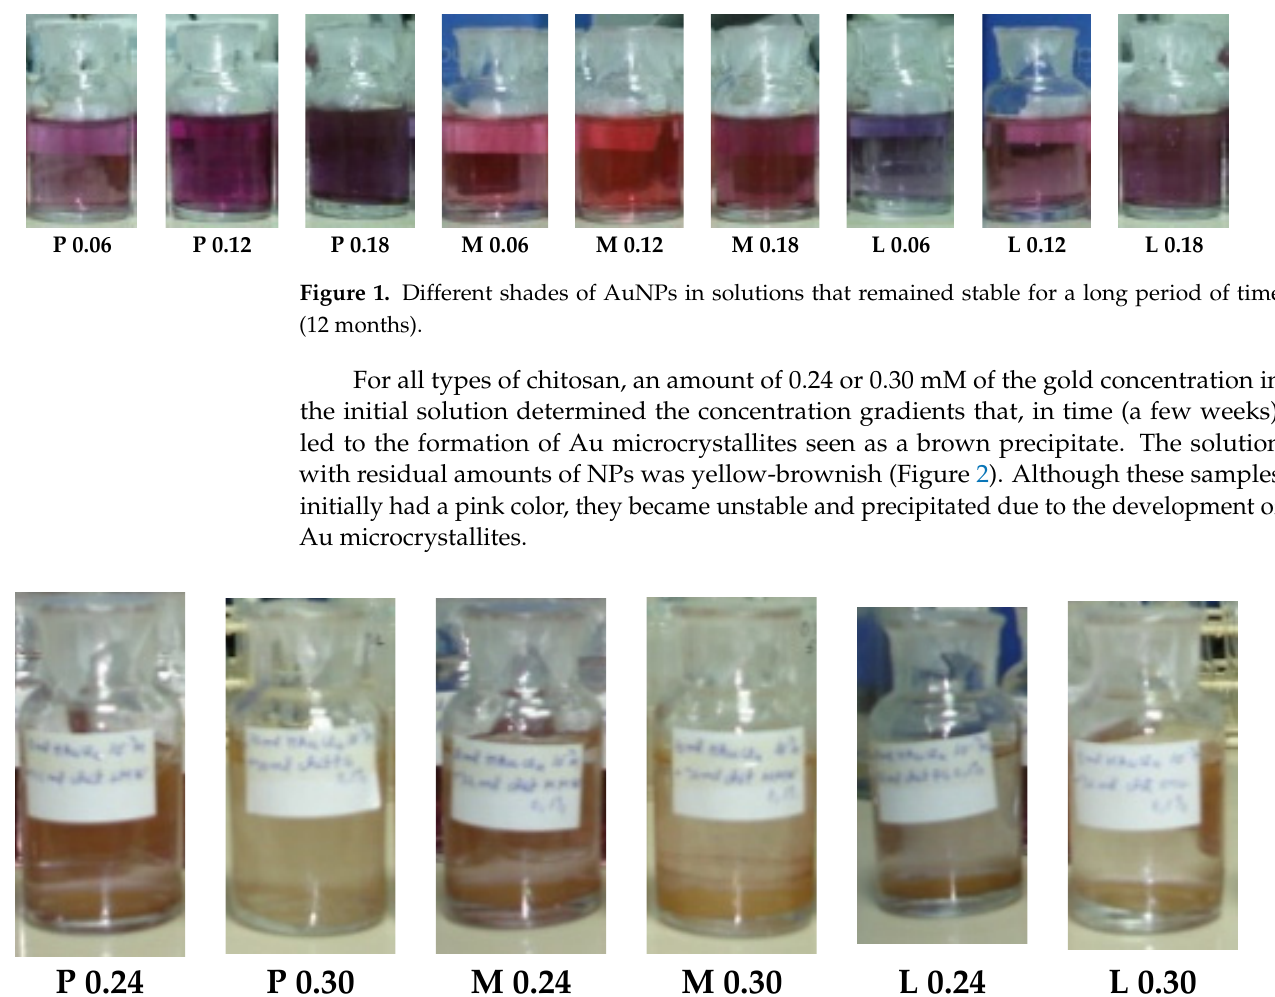
Figure 2. AuNP solutions with a concentration of 0.24 and 0.30 mM (unstable after a few weeks).